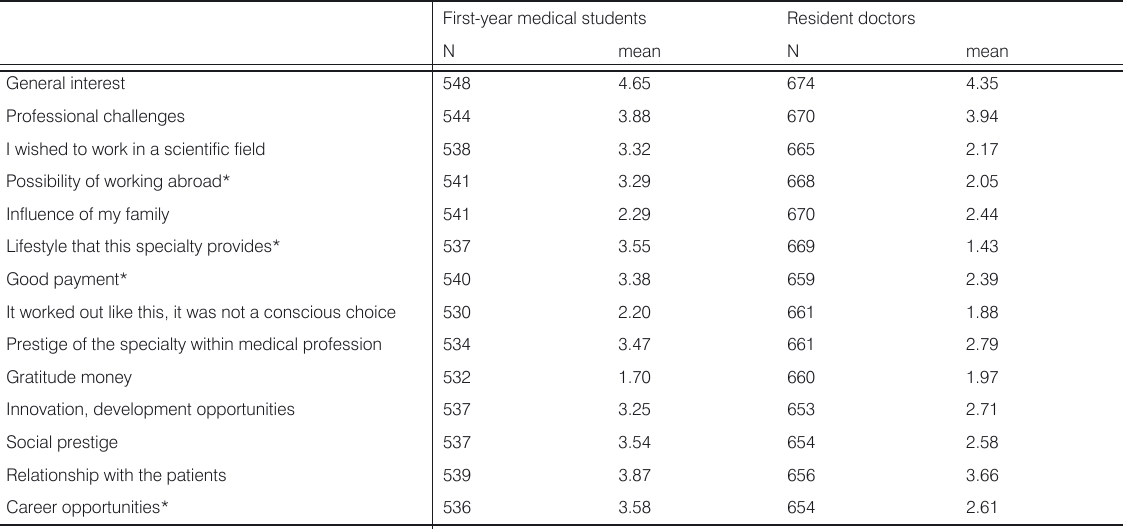
Table 3. Preferences to choose medical speciality: Which factors are to influence you? (first-year medical students) Which factors influenced your decision? (resident doctors). Please appraise the items, whether they influence or influenced the choice of medical speciality: 1 = not at all, 5 = decisively. The table shows mean values.